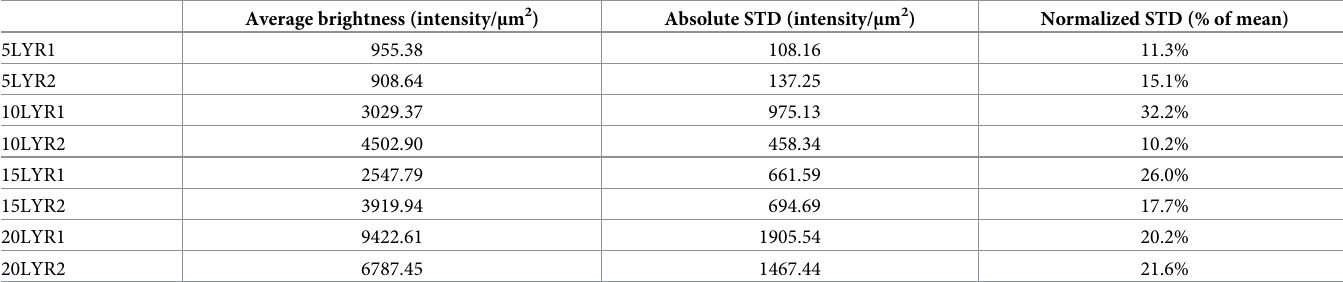
Table 2. Average fluorescence brightness, absolute standard deviations, and normalized standard deviations for the coated balloons (max possible bright- ness = 12117.4/ μ m 2